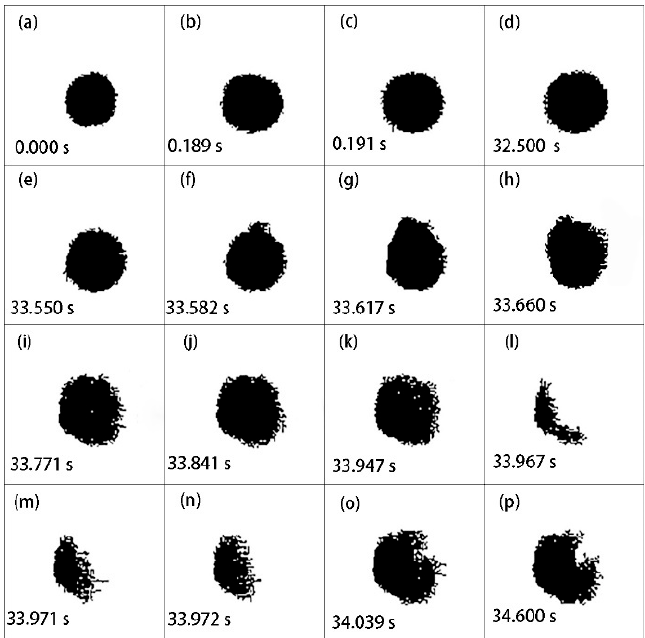
Figure 4. Representative pictures of laser-induced ignition and combustion processes of an individual aluminum particle using digital imaging treatment. The initial diameter was 6.82 µ m. The laser power density was 5.88 × 10 5 W / cm 2